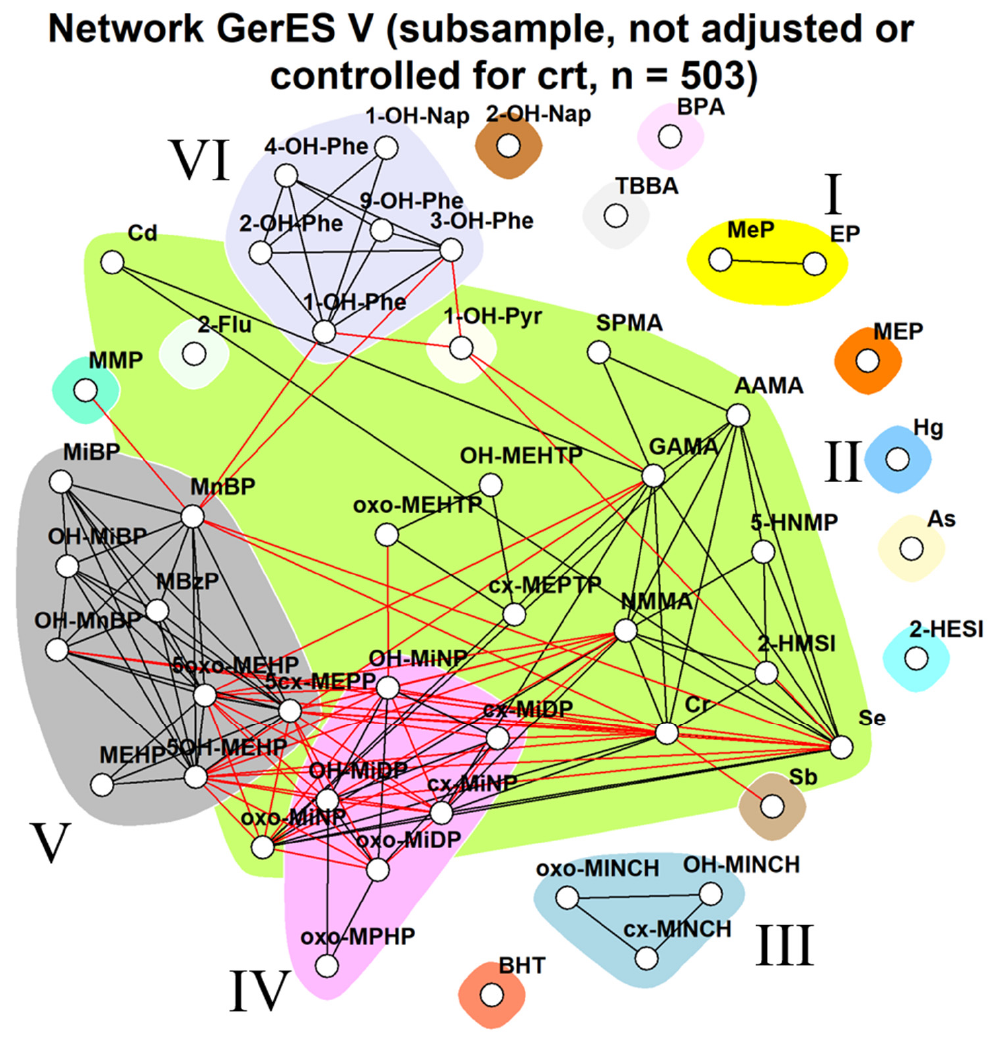
Figure A5. Network of GerES V subset, without application of any correction for creatinine. Black lines indicate dependency between nodes (biomarkers) within a community; red lines indicate dependency between nodes in different communities.